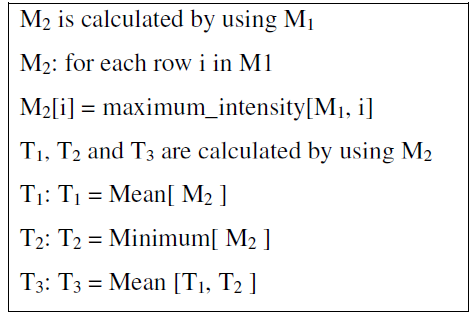
Figure 10: Input linguistic variable- mean